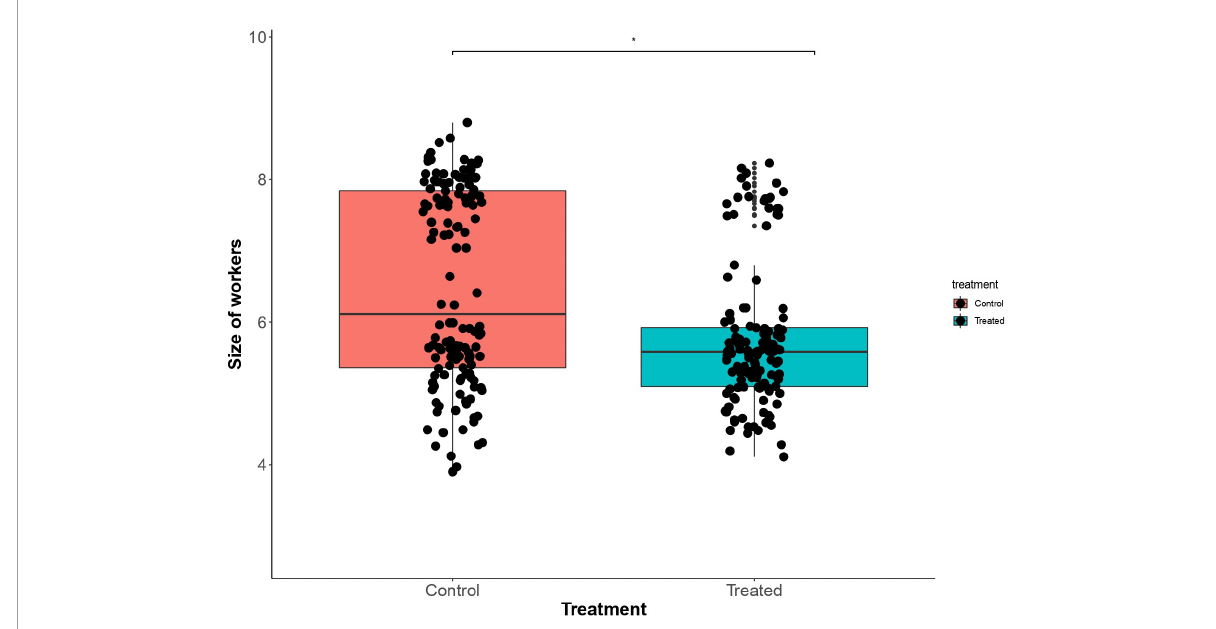
FIGURE2 Bees exposed to Sulfoxaflor present a smaller size compared to bees not exposed to the insecticide (control). * p = 0.02.